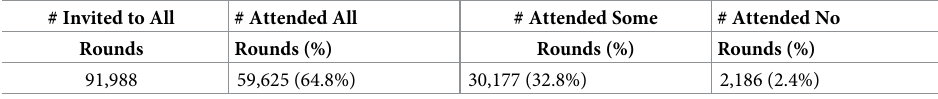
Table 2. Mammography screening attendance in the Capital Region of Denmark from